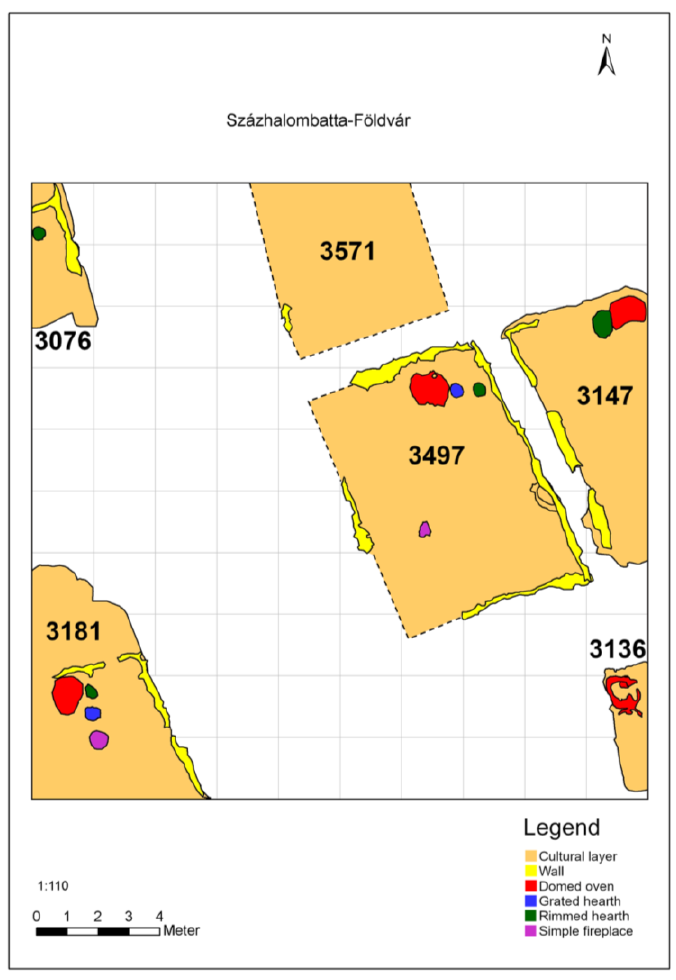
Figure 2. Location of house ID 3497 within the excavation trench (edited after [45]).